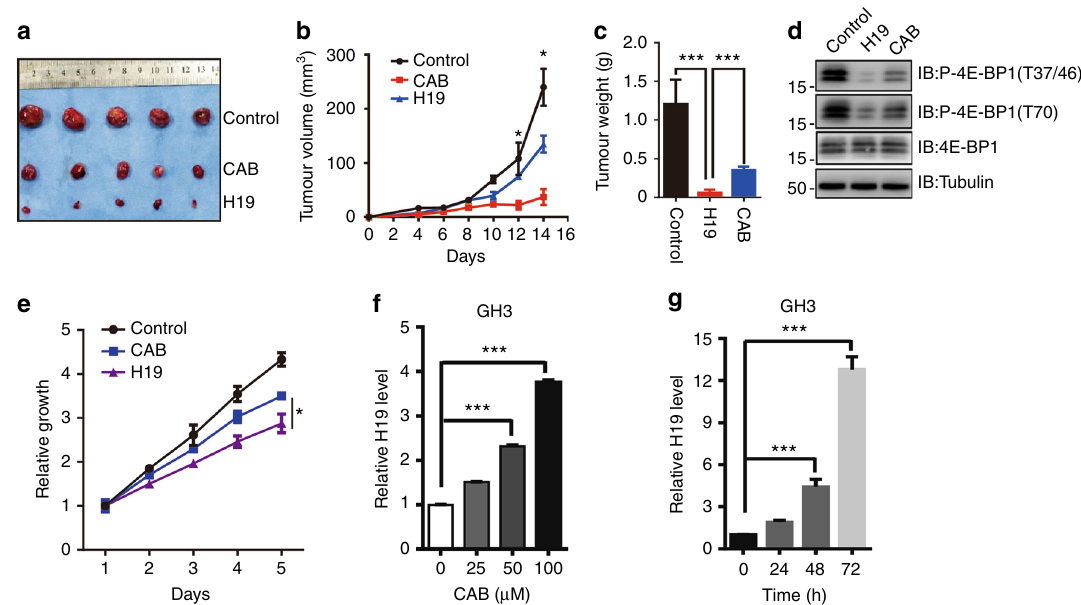
Fig. 7 H19-induced tumour suppression is superior to CAB treatment. a H19 suppresses GH3 tumour growth more potently than CAB treatment (0.75 mg/ kg) in vivo. First, 1 × 10 6 GH3 cells with or without H19 stable overexpression were injected subcutaneously into nude mice. The normal GH3 cell mice were divided into two groups that received either gavage with saline solution or cabergoline. b The xenograft tumour size was monitored every other day (volume = width 2 × length× 1/2). At the end of the experiment, the xenograft tumours were dissected, photographed and weighed ( c ). d 4E-BP1 phosphorylation is more intensely suppressed in xenograft tumours treated with H19 than those treated with CAB. Some of the tumour tissues were homogenized in lysis buffer with a tissue homogenizer; then, the samples were centrifuged, and the supernatant was collected and used for immunoblot analysis with antibodies against total 4E-BP1 and phosphorylated 4E-BP1 Thr37/36 and Thr70. Tubulin was used as the loading control. e H19 suppresses GH3 cell proliferation more potently than CAB treatment (50 μ M) in vitro. f , g CAB induces H19 expression in GH3 cells in both a dose-dependent ( f ) and time-dependent ( g ) manner. Total RNA was extracted from GH3 cells, followed by CAB treatment at different CAB doses and periods of time. qRT-PCR was employed to measure the H19 expression level in GH3 cells after CAB treatment. Relative H19 expression was normalized to actin expression. Error bars are the mean ± SEM values, *** p <